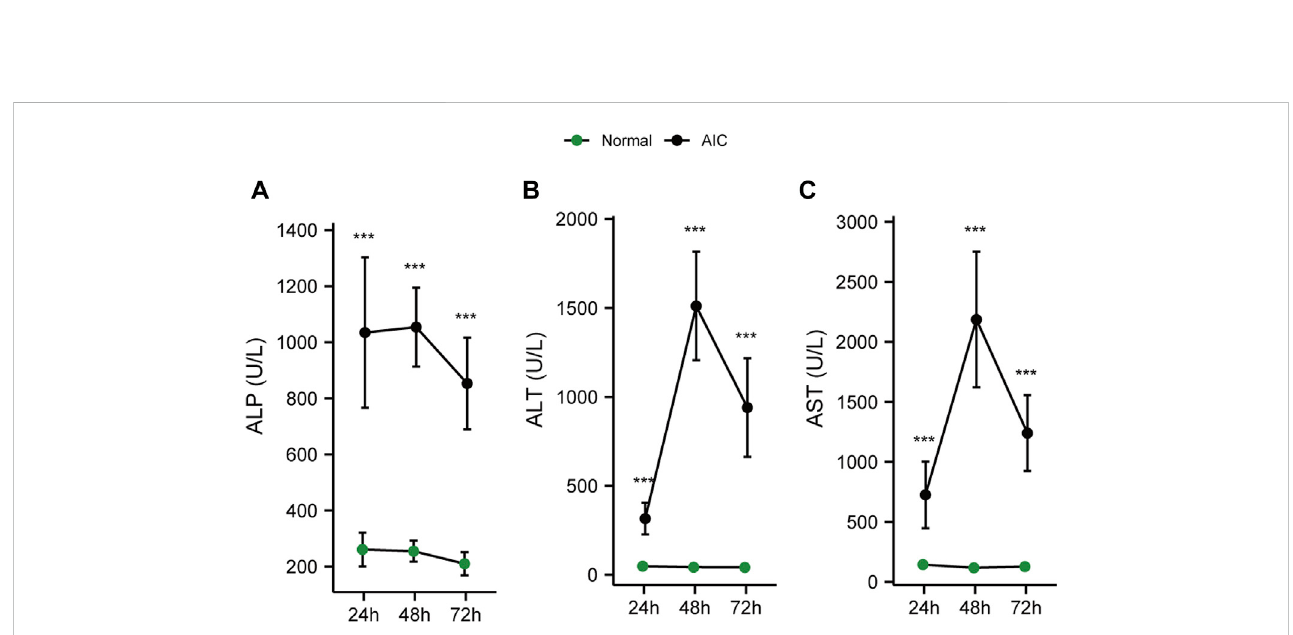
FIGURE 7 Dynamic chart of serum cholesterol and hepatic injury-related indicators in rats. (A) ALP dynamic change, (B) ALT dynamic change, (C) AST dynamic change.